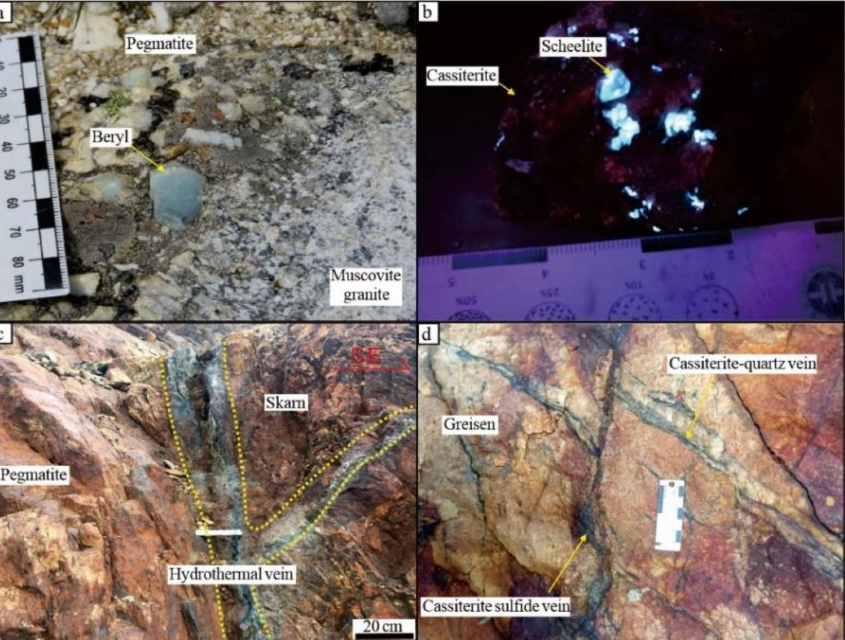
Figure 4. Typical mineralization at Cuonadong deposit. ( a ): The contact zone between muscovite granite and pegmatite, in which a beryl crystal has a hexagonal section. ( b ): Skarn-type ores under ultraviolet light showing scheelite (distinct light blue color). ( c ): Ore-bearing hydrothermal veins interspersed in viritic rock and skarn. ( d ): In the greisen,the cassiserite-quartz vien was cut by the cas-siserite sulfide